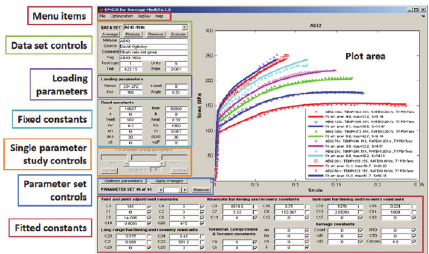
Figure 2: The logical groupings of controls in the DMGfit GUI.